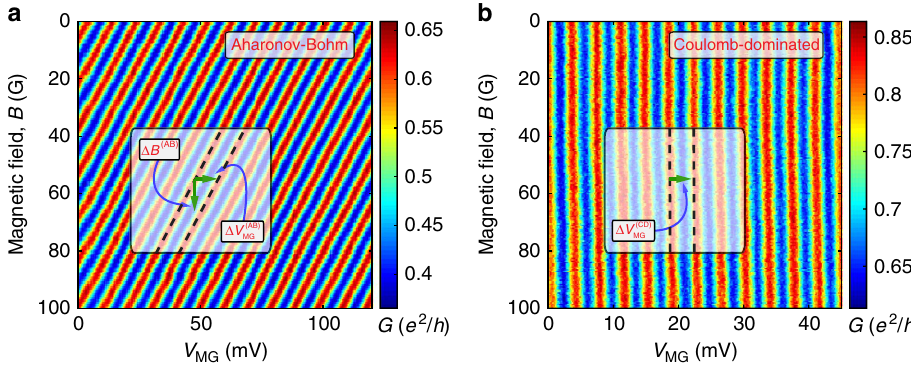
Figure 2 | Conductance versus modulation-gate voltage d V MG and magnetic field d B measured with Aharonov Bohm dominated and Coulomb- dominated devices. ( a ) 2D conductance measured with the FPI with an Ohmic contact in its centre (seen in Fig. 1b) at B ¼ 4.7T. This plot shows a clear AB and D B (AB) are marked accordingly. ( b ) 2D conductance measured behaviour: constant-phase lines are marked with grey lines and the AB periods D V AB ð Þ MG with the bare FPI (seen in Fig. 1a) at B ¼ 4.7T. This plot shows a clear CD behaviour with no dependence of the conductance on magnetic field; constant- is marked accordingly. phase lines are marked with grey lines and the CD period D V CD ð Þ MG